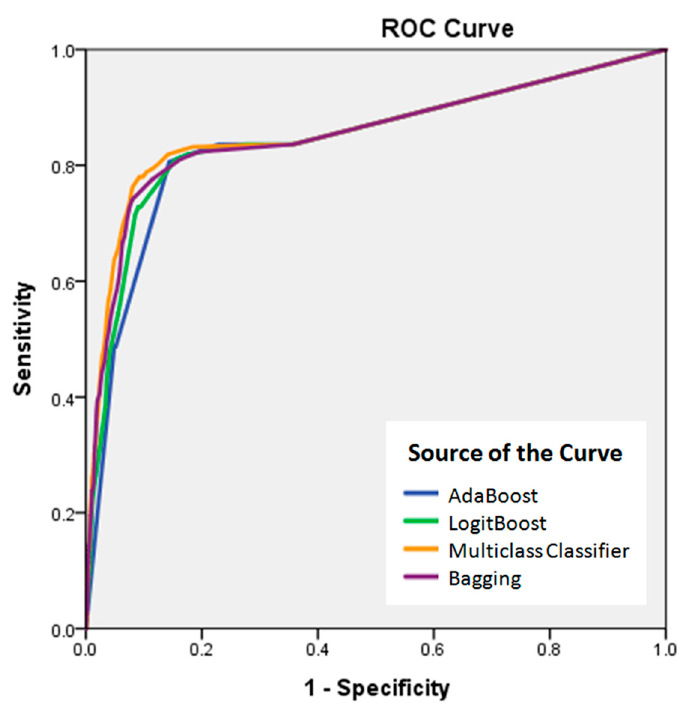
Figure 7. Receiver operating characteristic (ROC) curve of the landslide susceptibility maps created using four algorithms from the Meta classifiers.